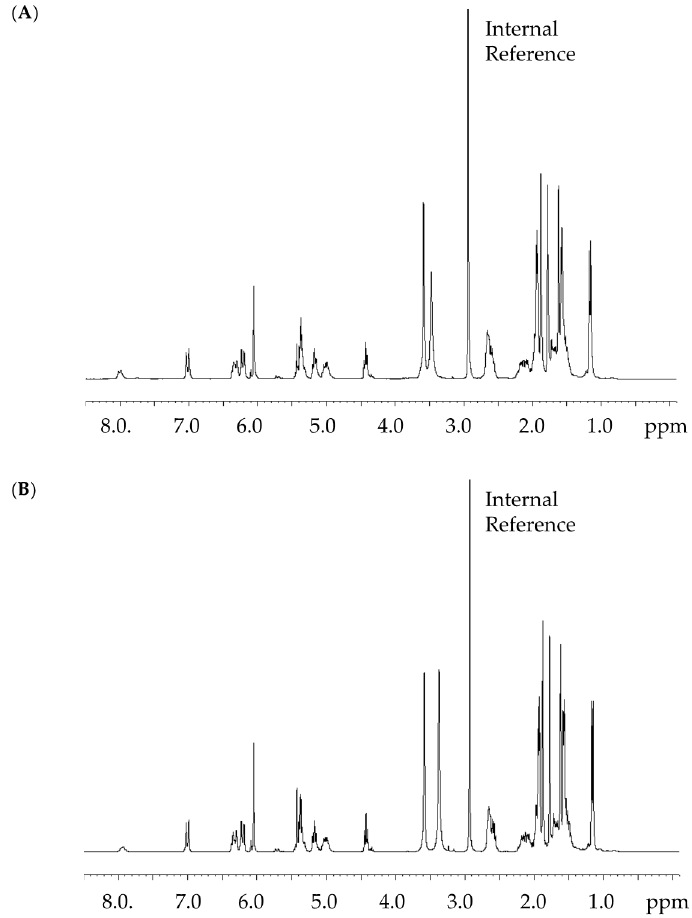
Figure 3. 1 H NMR spectra (300 MHz) of CorA batch A ( A ) and B ( B ) in acetonitrile- d 3 / D 2 O (6:1) with the internal reference compound dimethyl sulfone.